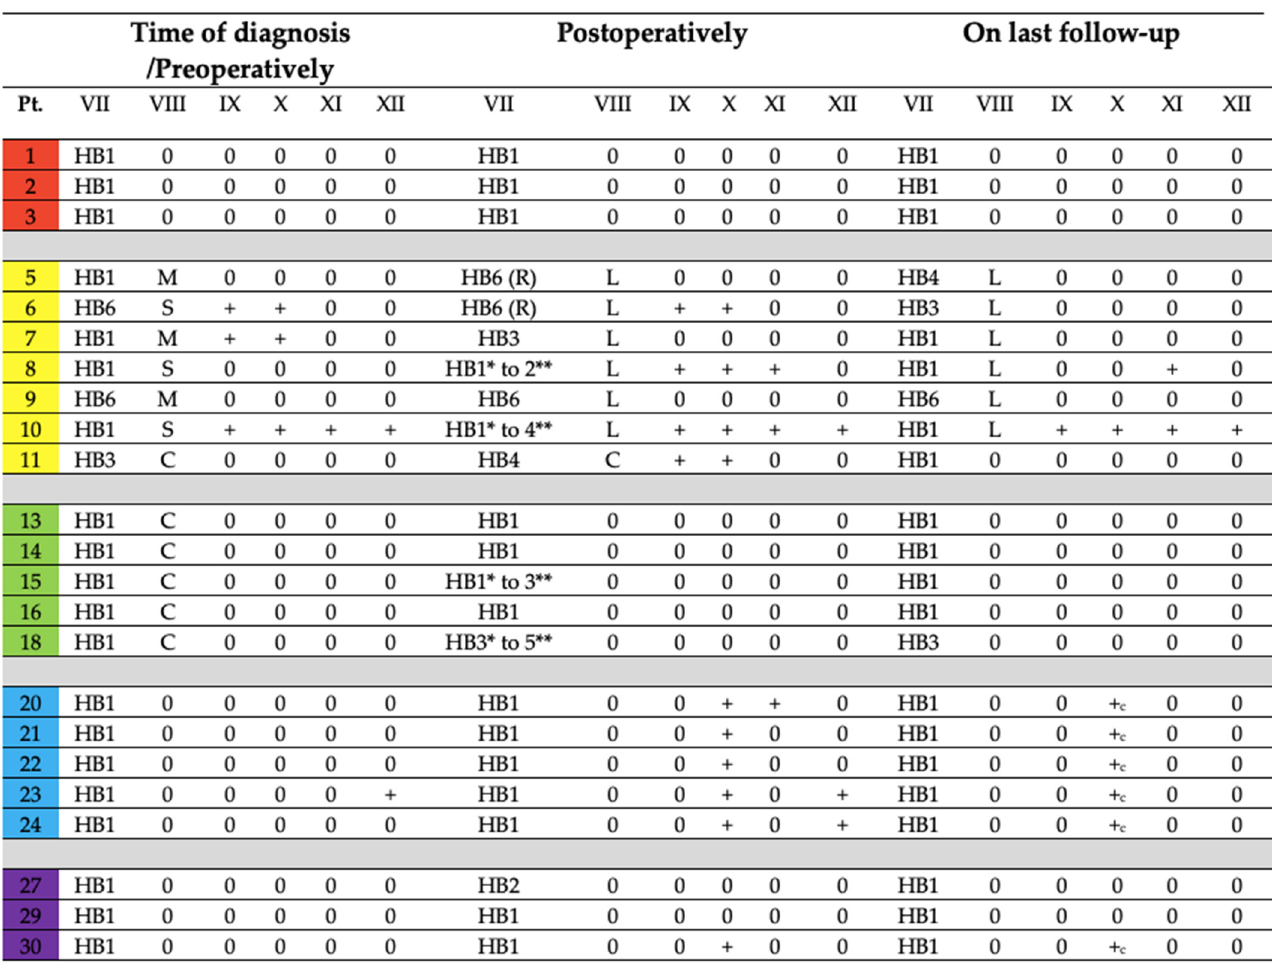
Figure 2. Status of cranial nerve function in patients who underwent surgery. Color key: Red = CBPGL; Yellow = JPGL; Green = TPGL; Blue = VPGL; Purple = Multiple PGLs(HB: House-Brackmann; M: Mixed Hearing Loss; C: Conductive Hearing Loss; S: Sensorineural Hearing Loss; R: Reconstructed; L: Labyrinthectomy leading to deafness; *: early postoperative function; **: 10 week postoperative function; + c : compensated nerve dysfunction).